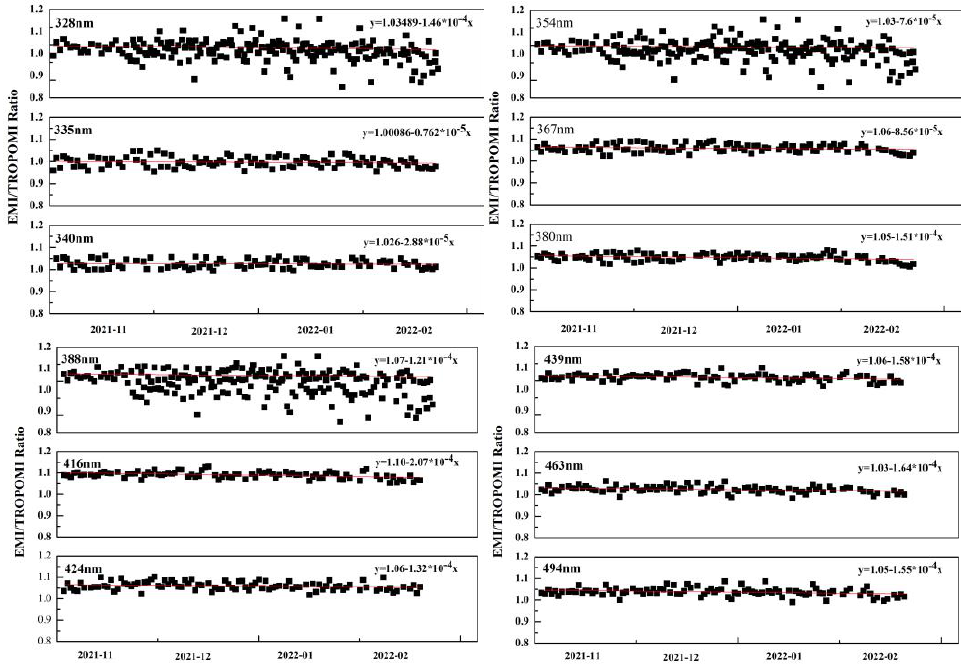
Figure 11. Time series of reflectance ratios of EMI-2 to TROPOMI after spectral adjustment factor and RTM-based correction.